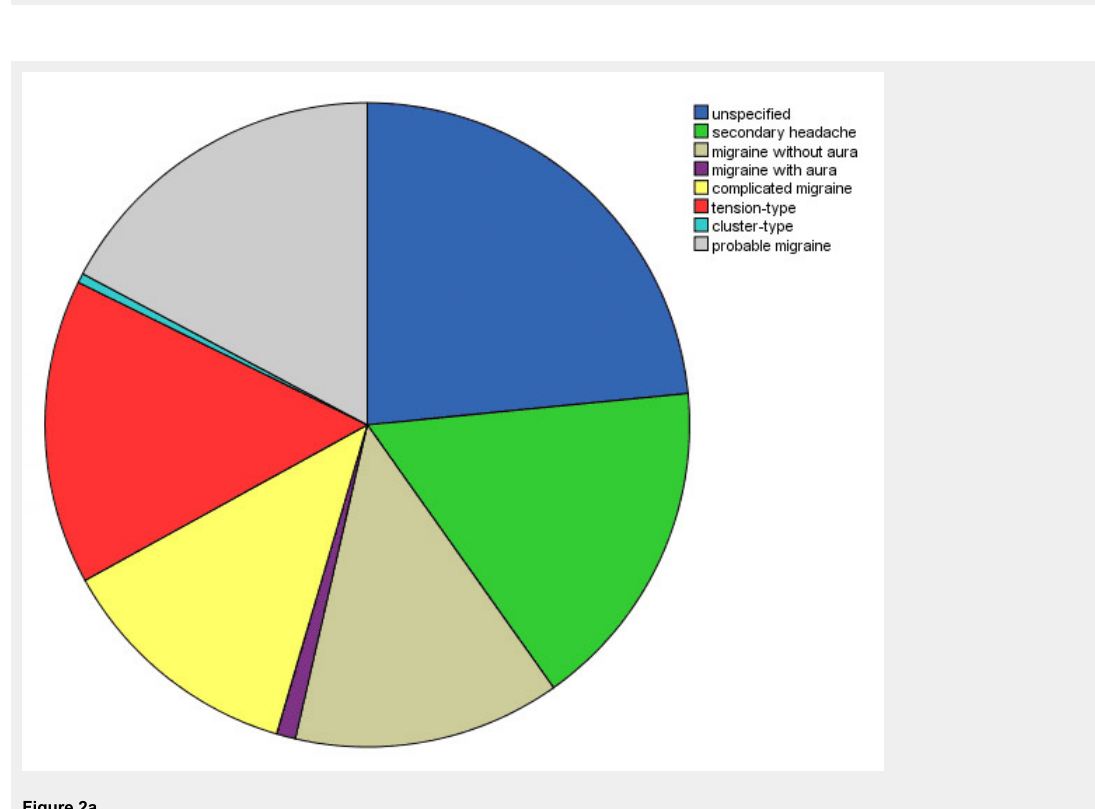
Figure 2a Type of headache seen in our patient